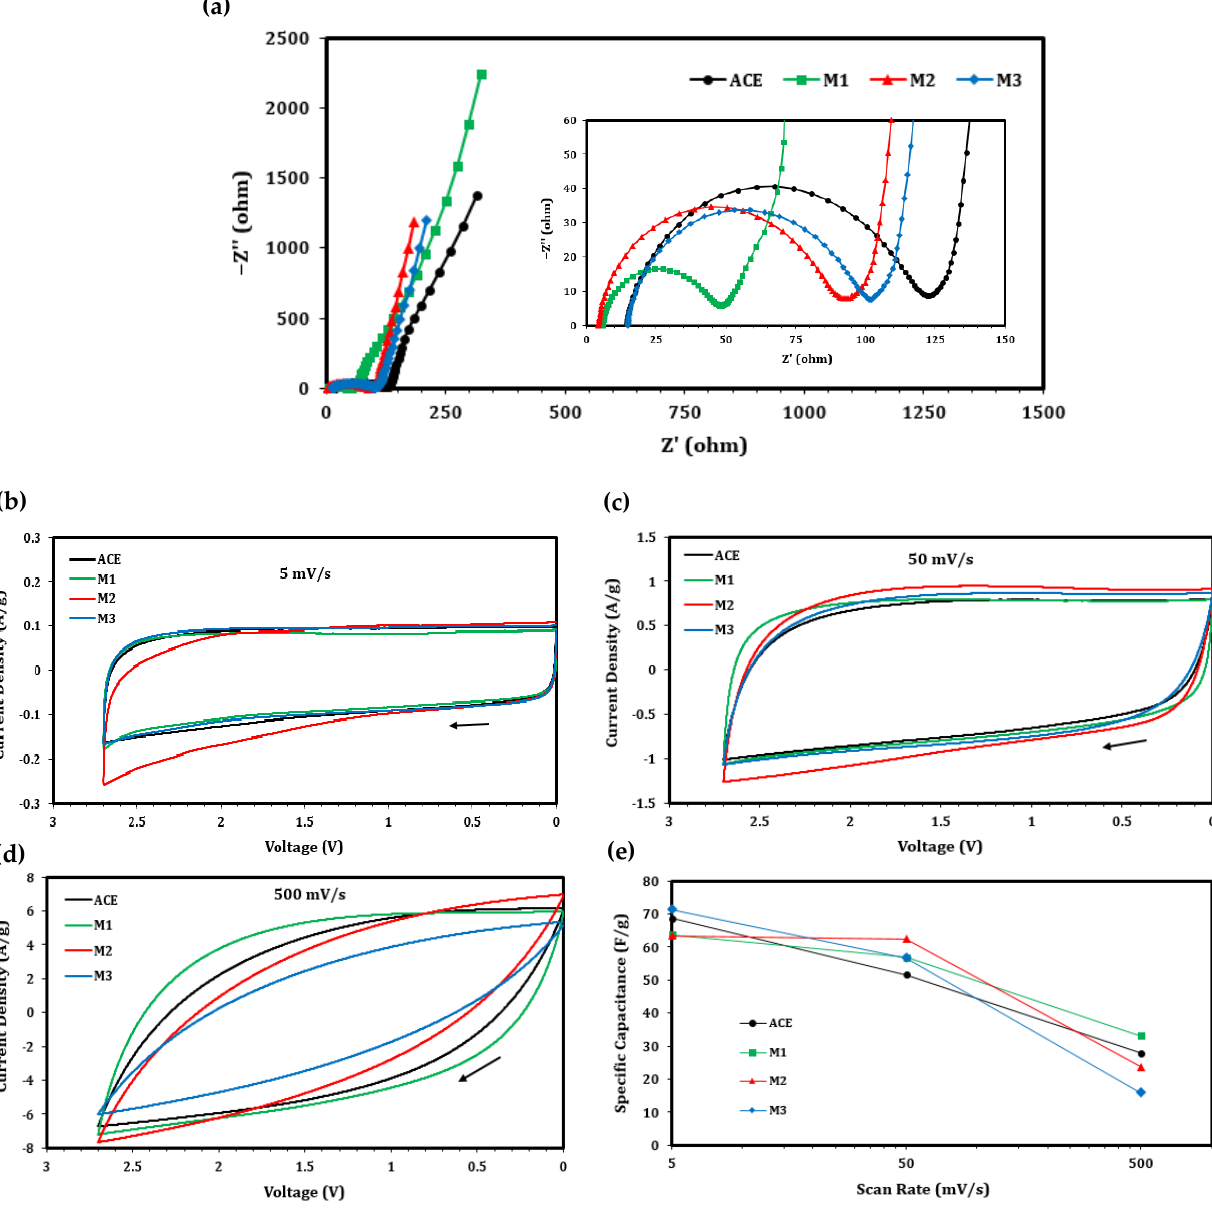
Figure 4. Nyquist plot ( a ) with zoomed high-to-mid frequency data (inset); cyclic voltammetry curves obtained at 5 mV s − 1 ( b ), 50 mV s − 1 ( c ), and 500 mV s − 1 ( d ), and average cathodic current- specific capacitances ( e ) of ACE, M1, M2, and M3. Arrows indicate beginning and sweep direction of cyclic voltammetry.